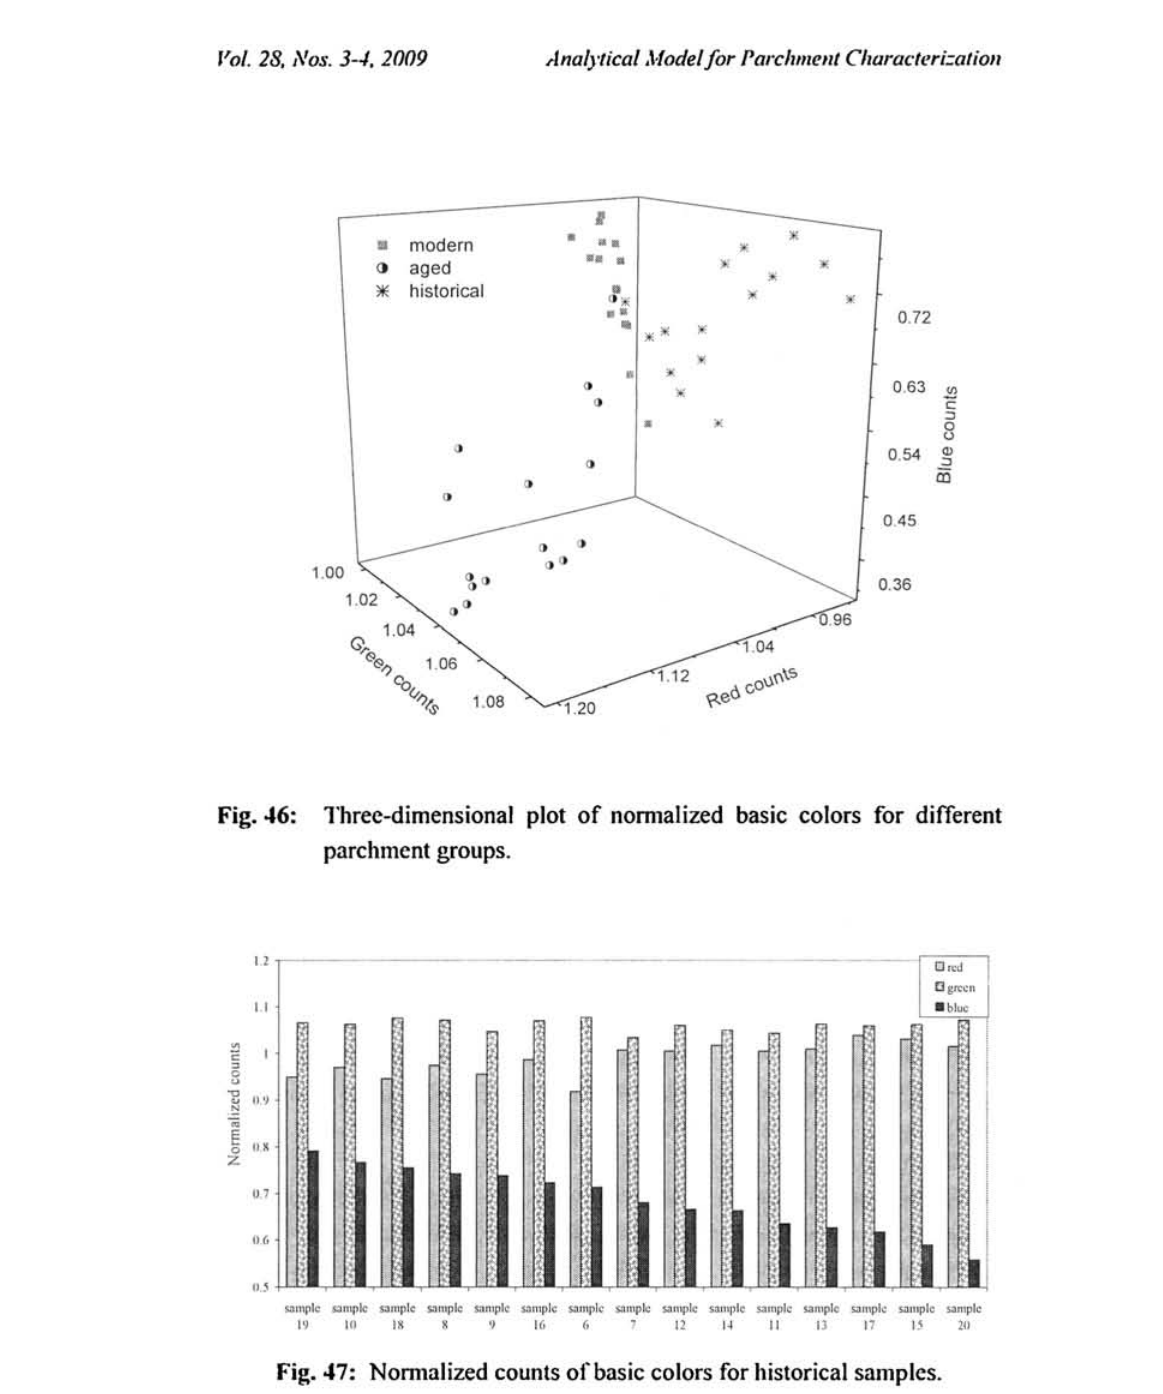
Fig. 47: Normalized counts of basic colors for historical